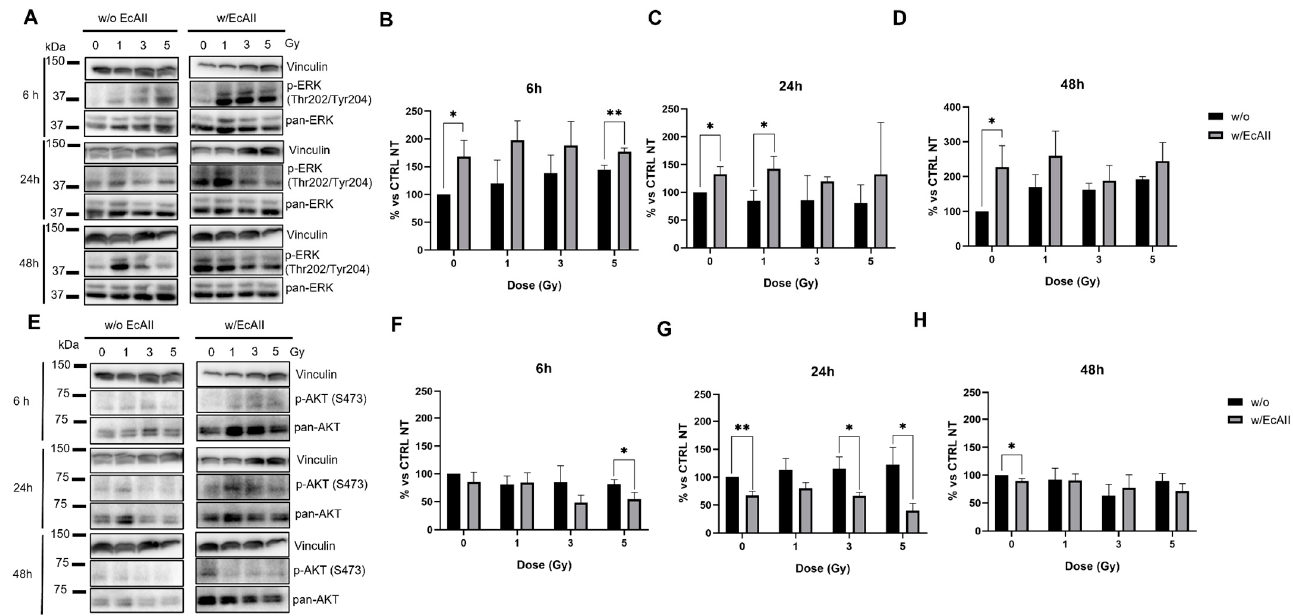
Figure 4. Metabolic response evaluation for Caco-2 cells exposed to different doses of X rays (0, 1, 3 and 5 Gy), without (w/o) or with 1 U/mL EcAII (w/EcAII) administered after radiation. ( A ) Illustrative Western blot images of phosphorylated ERK (T202/Y204) and pan-ERK. The densitometric analysis was performed by evaluating the p-ERK/total ERK ratio, with changes expressed relative to the unirradiated and untreated control at each time point (% vs. CTRL NT). Samples w/o EcAII (black bar) and with EcAII (gray bar) were harvested: ( B ) 6 h after irradiation; ( C ) 24 h after irradiation; and ( D ) 48 h after irradiation. ( E ) Illustrative Western blot images of phosphorylated AKT (S473) and pan-AKT. The densitometric analysis was performed by evaluating the p-AKT/total AKT ratio, with changes expressed relative to the unirradiated and untreated control at each time point (% vs. CTRL NT). Samples in the absence of EcAII (black bar) and with EcAII (gray bar) were harvested: ( F) 6 h after irradiation; ( G ) 24 h after irradiation; ( H ) and 48 h after irradiation. Data reported are mean ± SD, obtained from at least three independent experiments. Statistical significance (Student’s t -test) was calculated by comparing the w/o and w/EcAII conditions for each dose and time point and is reported as follows: * p < 0.05, ** p < 0.01.